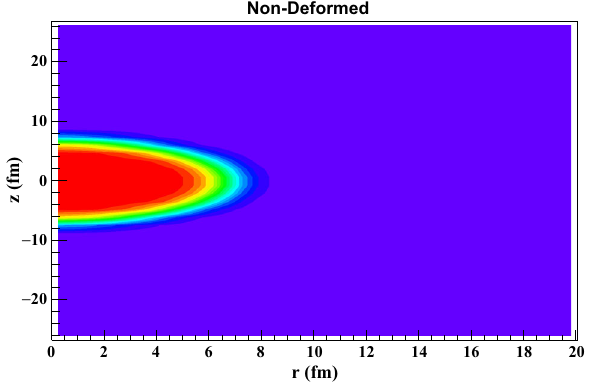
Fig. 1 Nuclear density contour in r − z plane of cylindrical coordinate system for non-deformed nucleus. We follow the VIBGYOR colour coding in this figure. Red means the highest value of nuclear density and violet represents the lowest nuclear